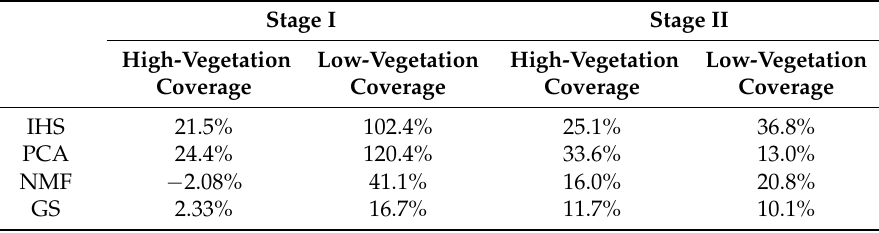
Table 14. Percent improvement in average gradient.